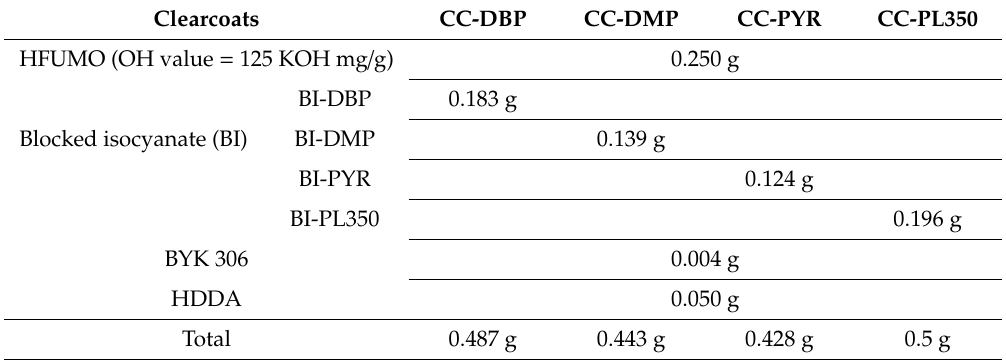
Table 1. Formulation of clearcoats including pyrazole-based blocked isocyanates (Bis) and